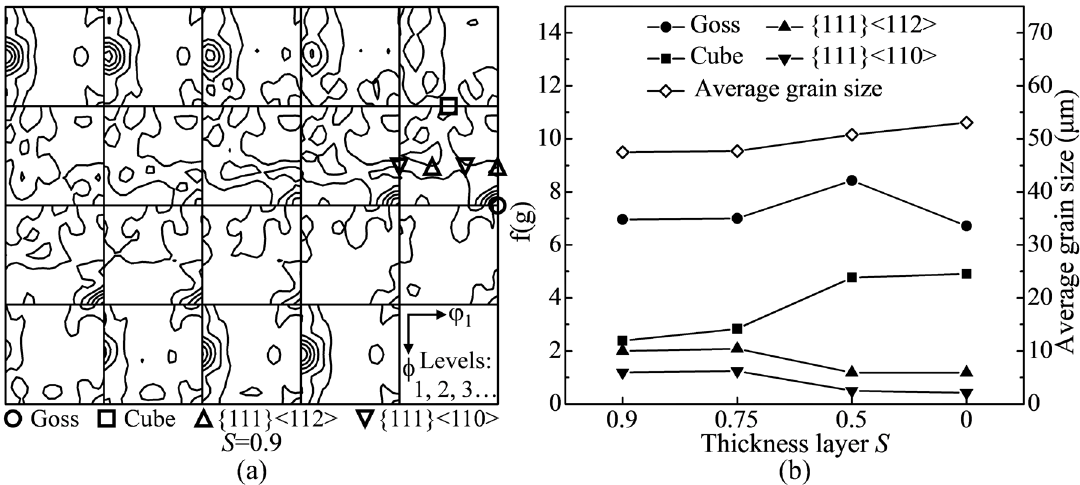
sections of ODFs at the S = 0.9 layer and (b) orientation densities of main texture components and average grain Figure 3. (a) Constant φ 2 size at different thickness layers in Fe-2.1 wt.% Si sheets after annealing at 850 °C for 10 min.